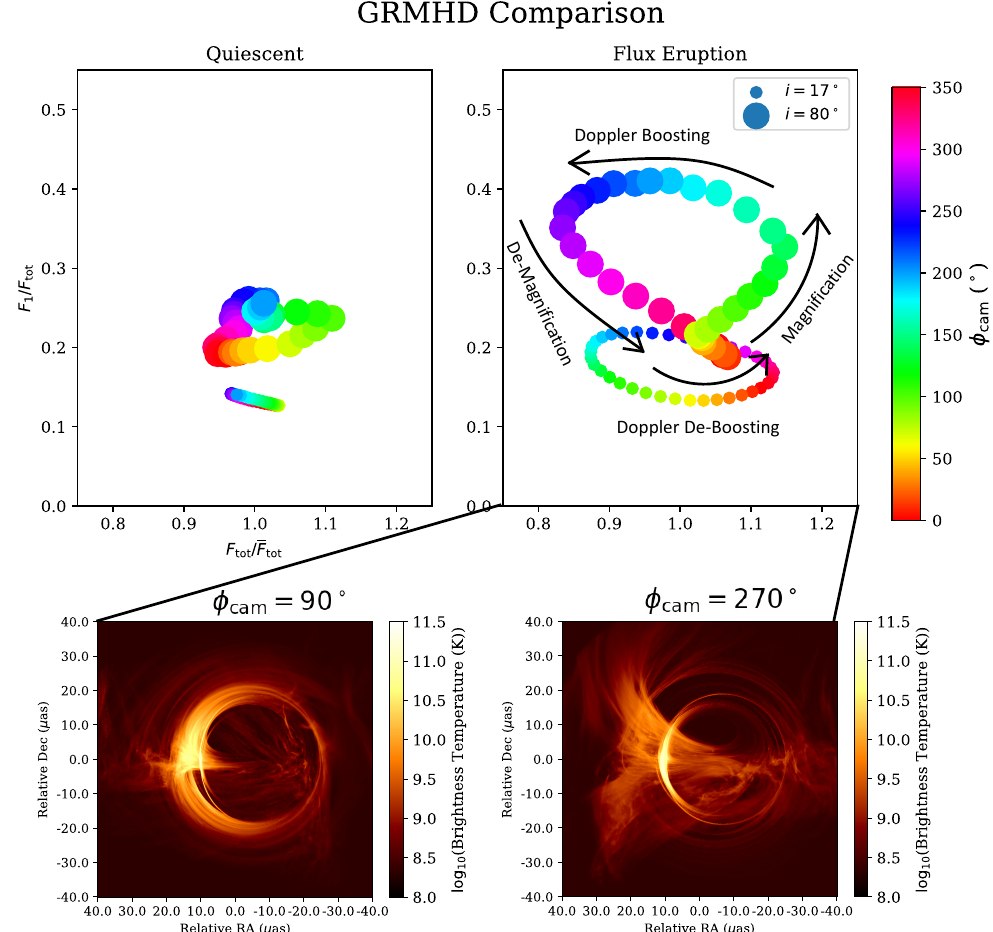
Figure 4. PFR curves for GRMHD ray-traced with full synchrotron emissivities (i.e., including magnetic field dependence). The results are similar to Figure 3, showing that the effects of magnetic field direction are insignificant in shaping the PFR for this example both in the quiescent state and during the flux